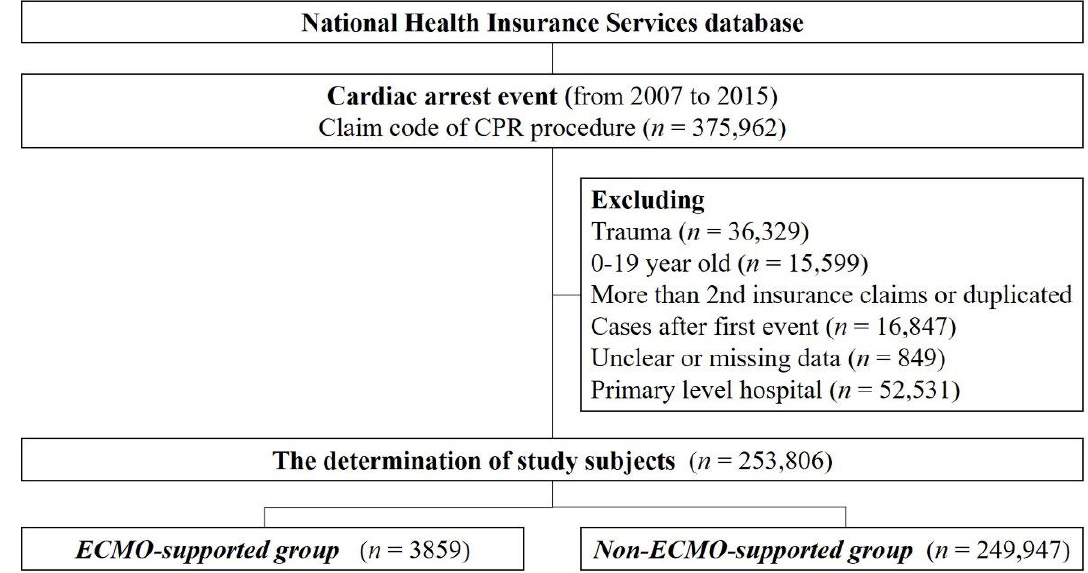
Figure 1. Flowchart of selection of study patients.